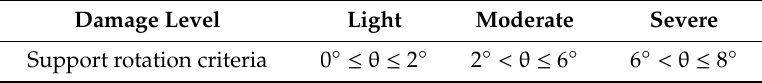
Table 9. Criteria of damage level according to UFC 3-340-02 [47].